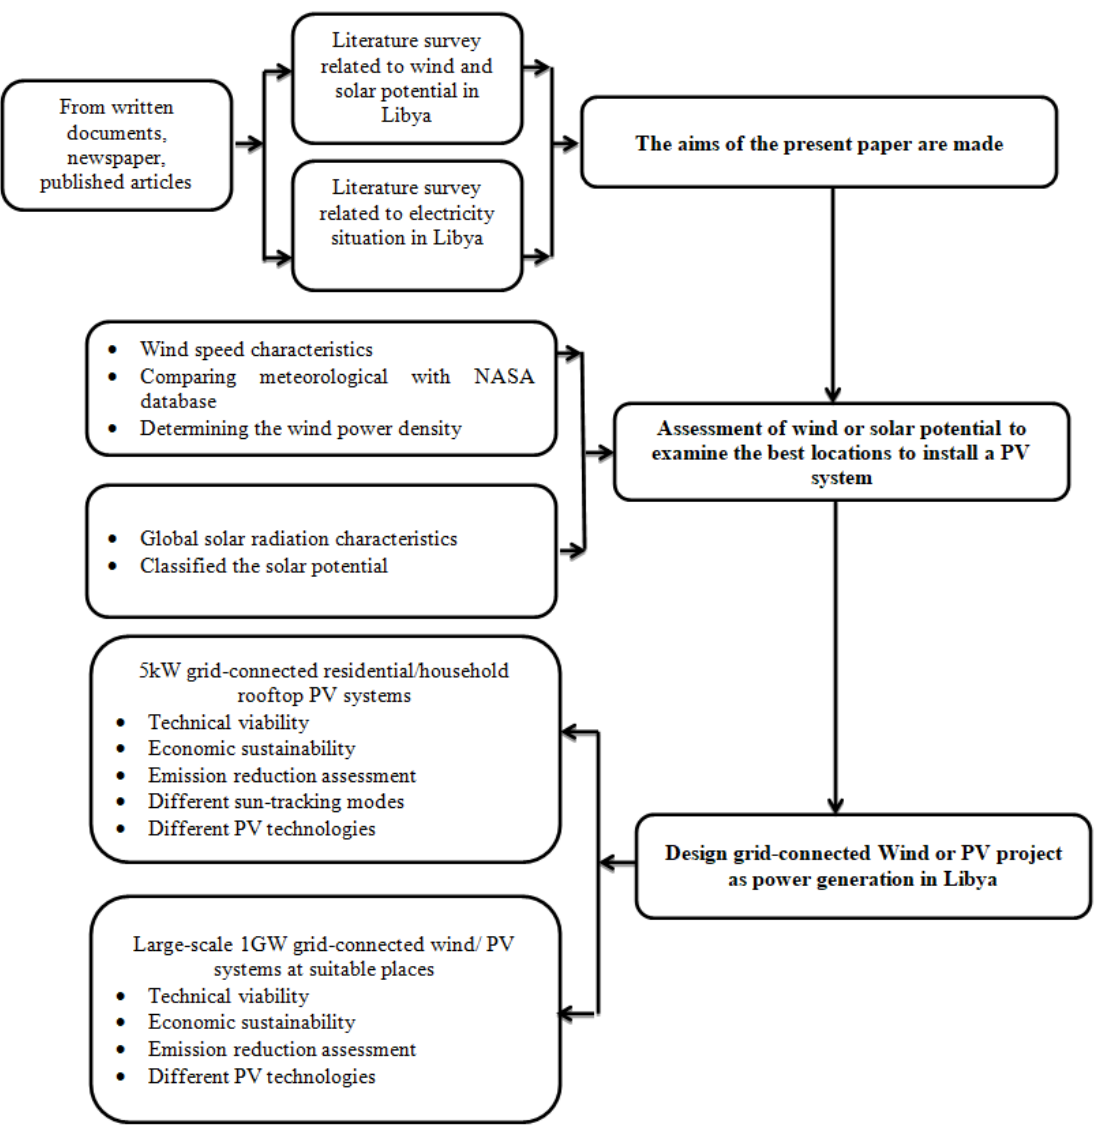
Figure 1. Schematic description for the proposed methodology.